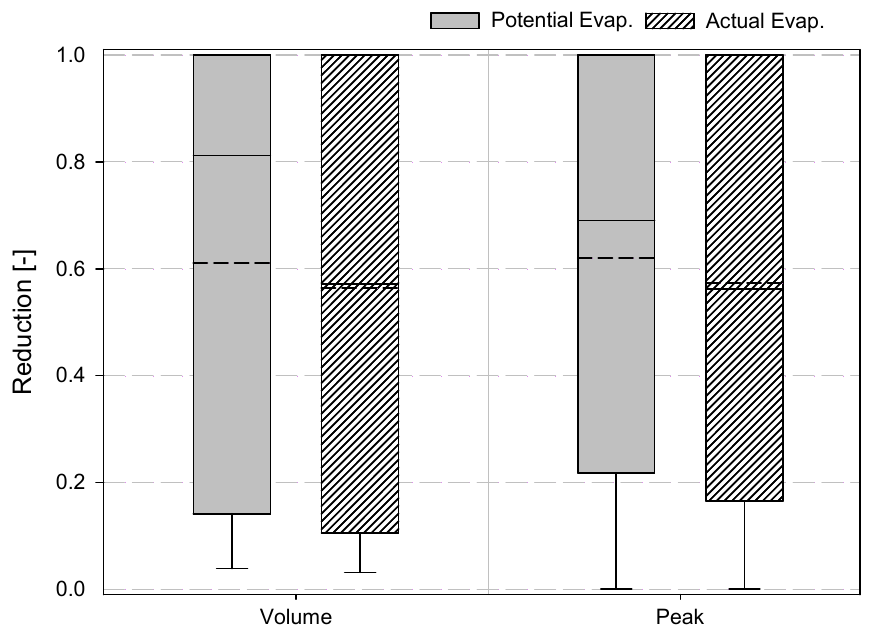
Figure 4. Non-parametric distribution of the volume and peak reduction rates simulated assuming the potential (grey box) and actual (hatched box) evapotranspiration at the single green roof scale. The solid and dashed lines within the box mark indicate the median and mean values, respectively.